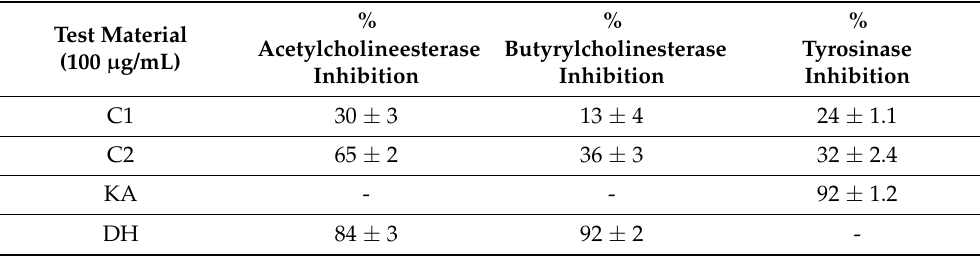
Table 2. Percentage inhibitory effect of C1 and C2.